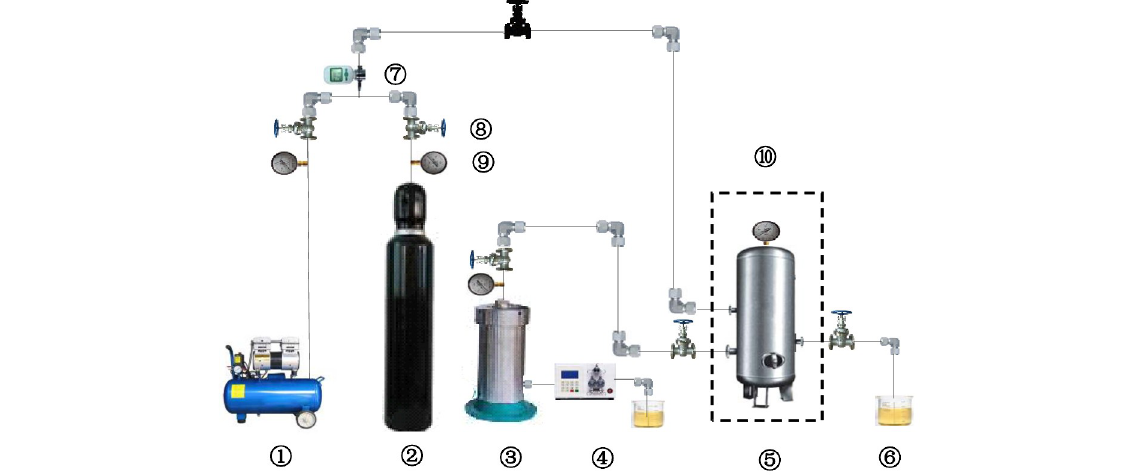
Fig 4. The experimental facilities of microbial oxygen consumption rate